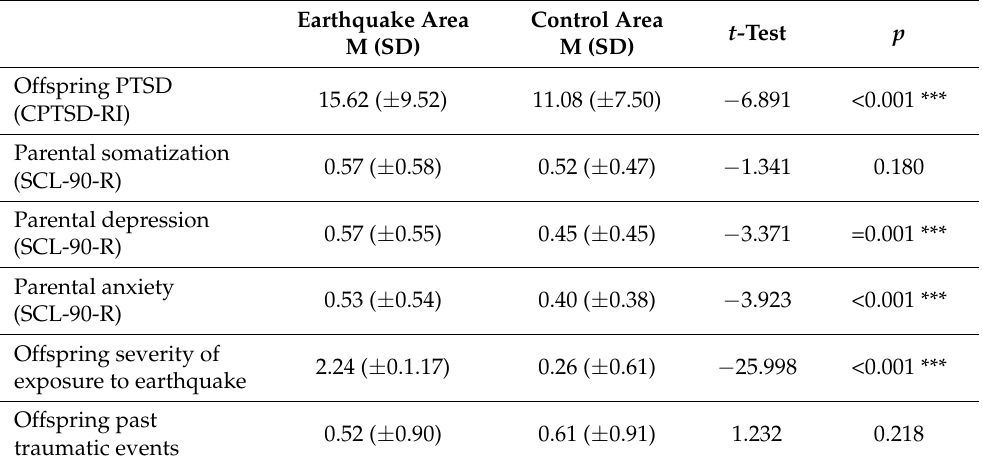
Table 1. Descriptive analyses of the main study